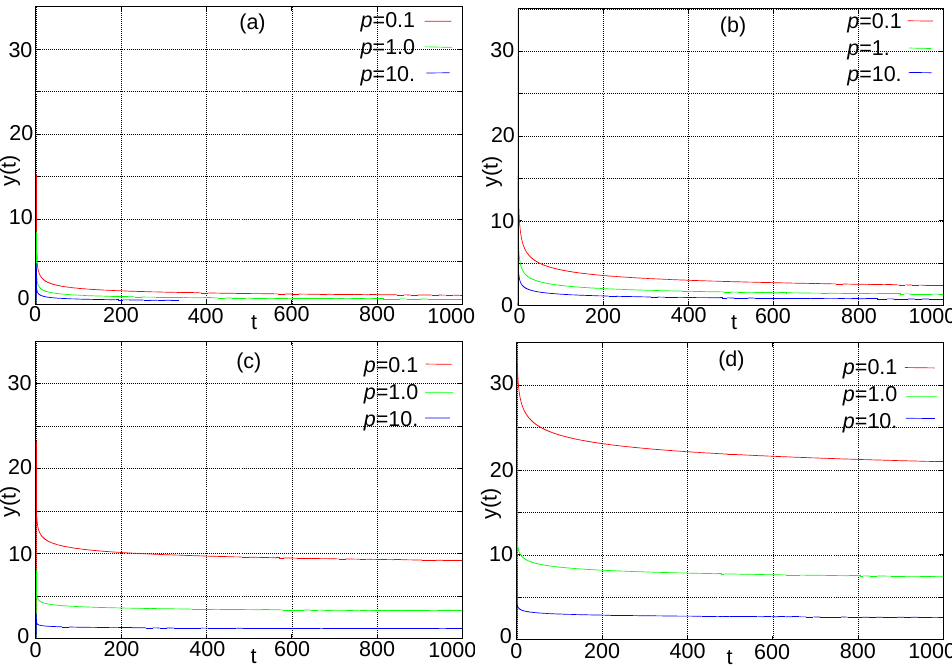
Figure 4. Simulation results for model (30) without the influence of a random process. The α - quenching by helicity ( γ = 0). The parameter p values are shown on the legends. The parameter D and β values on panels: ( a ) D = 20, β = 0.5; ( b ) D = 100, β = 0.5; ( c ) D = 20, β = 0.9; ( d ) D = 100, β =